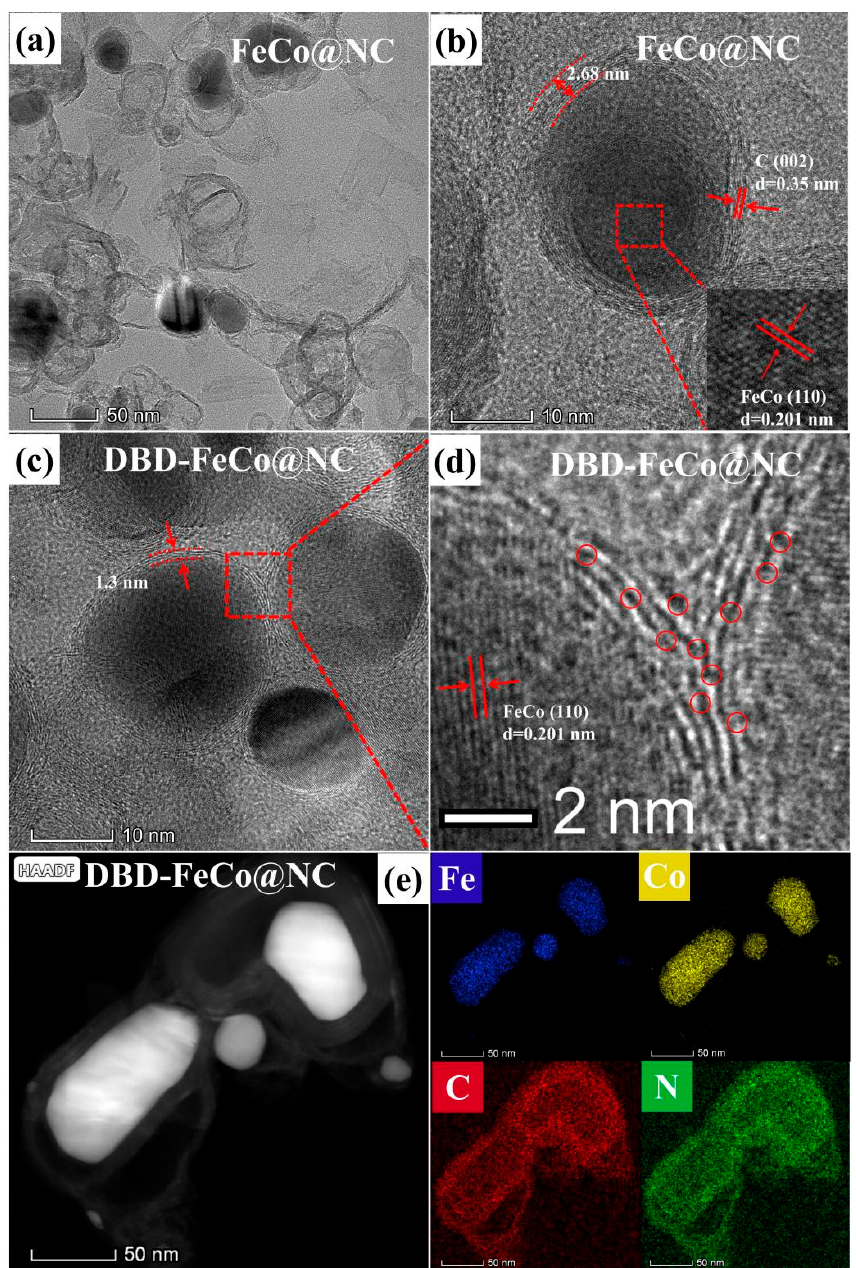
Figure 3. ( a ) Transmission electron microscopy (TEM) image for FeCo@NC, ( b ) high-resolution TEM (HRTEM) image for FeCo@NC, ( c , d ) HRTEM images for dielectric barrier discharge (DBD)-FeCo@NC, ( e ) HAADF-STEM image and the corresponding elemental mapping of DBD-FeCo@NC.